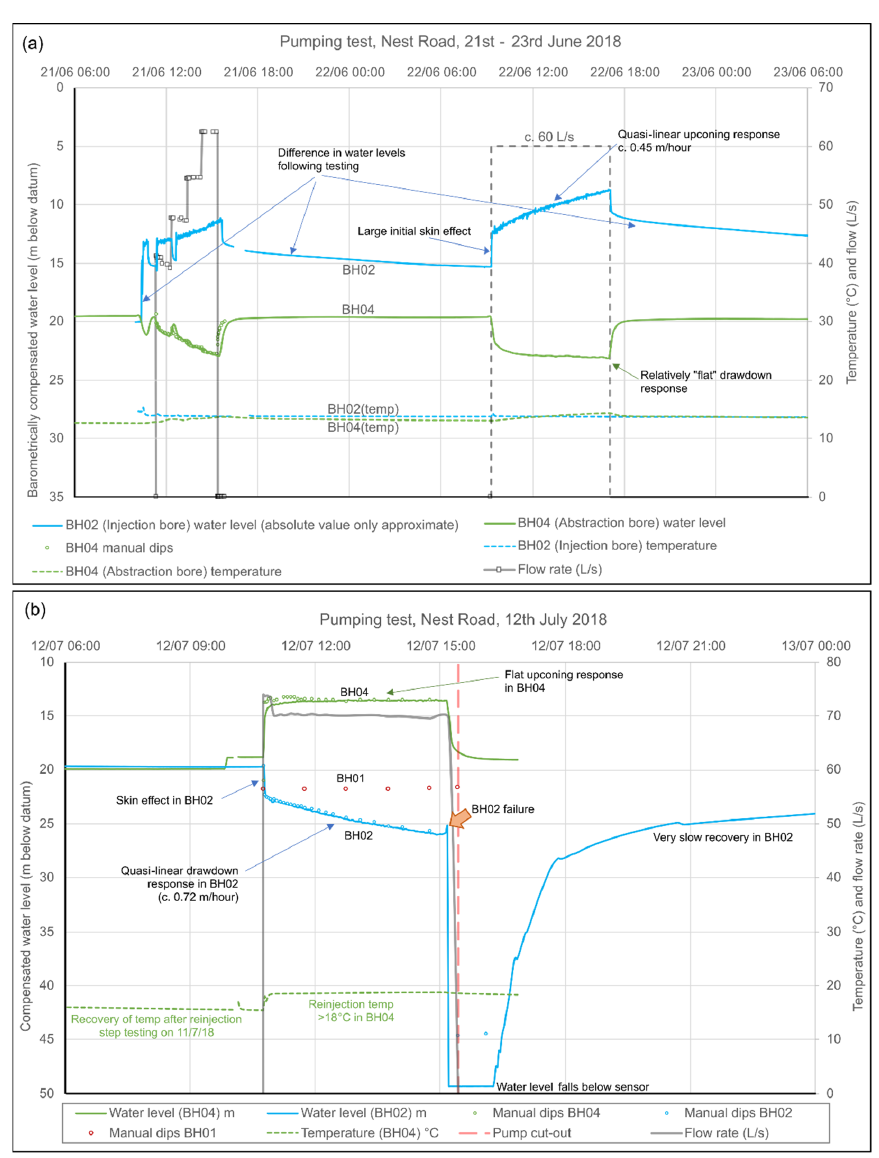
Figure 8. Hydrographs from short-term pumping tests of Nest Road BH02 and BH04 in ( a ) June 2018 (abstraction from BH04, reinjection to BH02) and ( b ) July 2018 (abstraction from BH02, reinjection